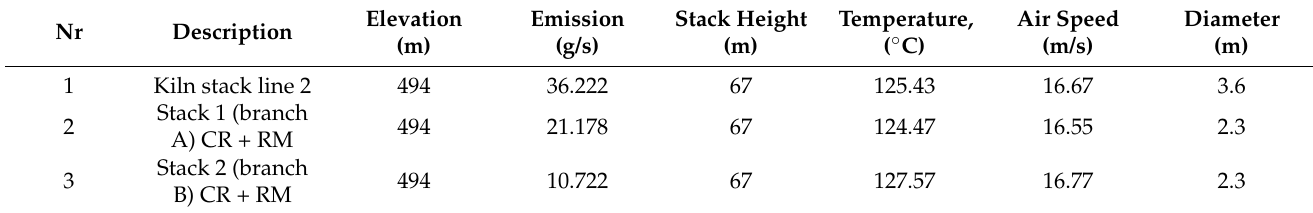
Table 6. Input data in Breeze AERMOD software—NOx.